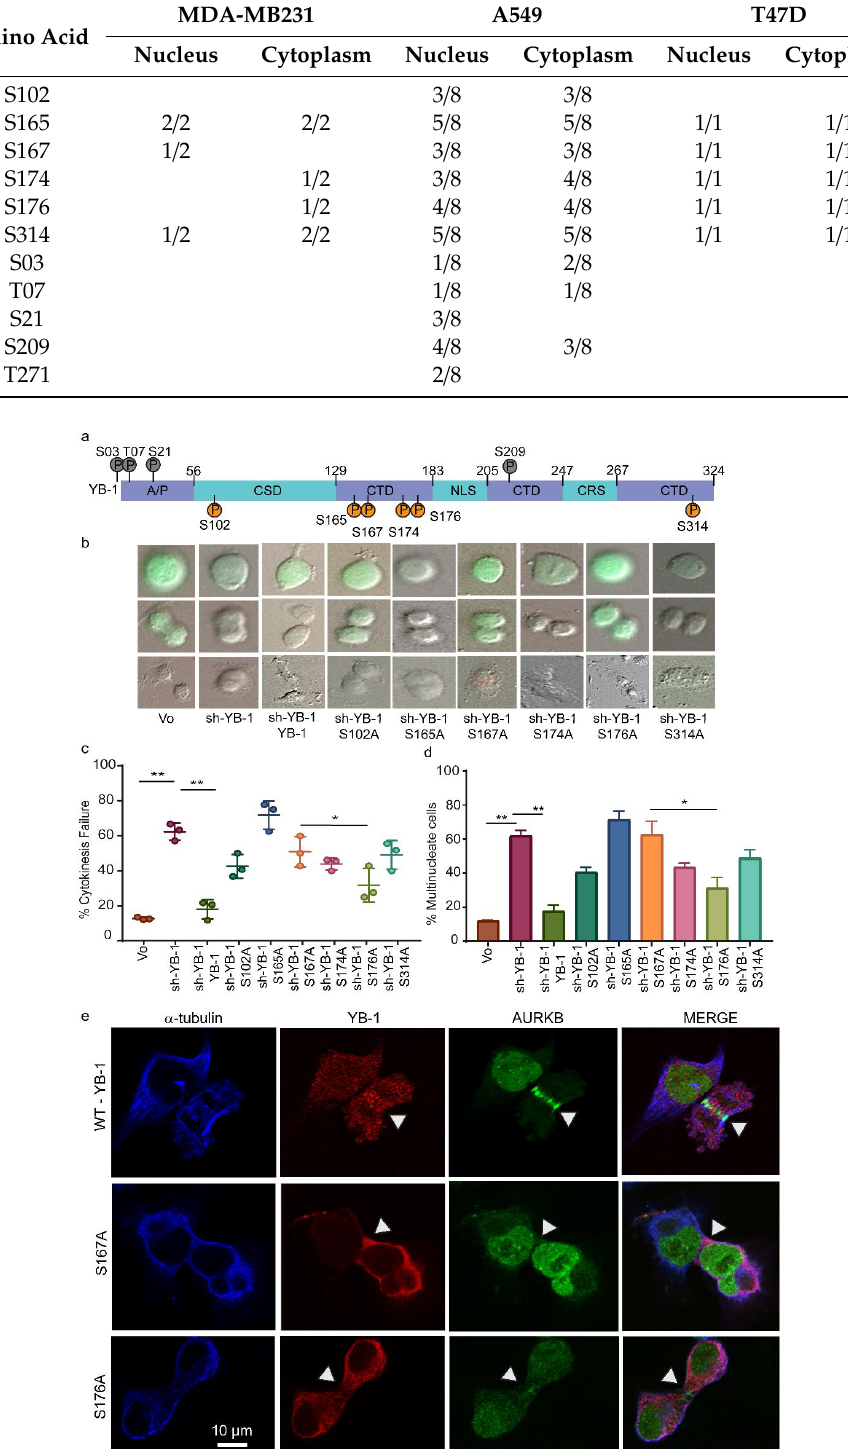
Figure 6. Phosphorylation defective YB-1 mutants cannot rescue cytokinesis failure following YB-1 depletion. ( a ) Schematic showing the YB-1 protein and the location of the phosphorylation sites detected in MDA-MB-231, A549 and T47D cells (Common: orange circles; summarized in Table 1, and rare: